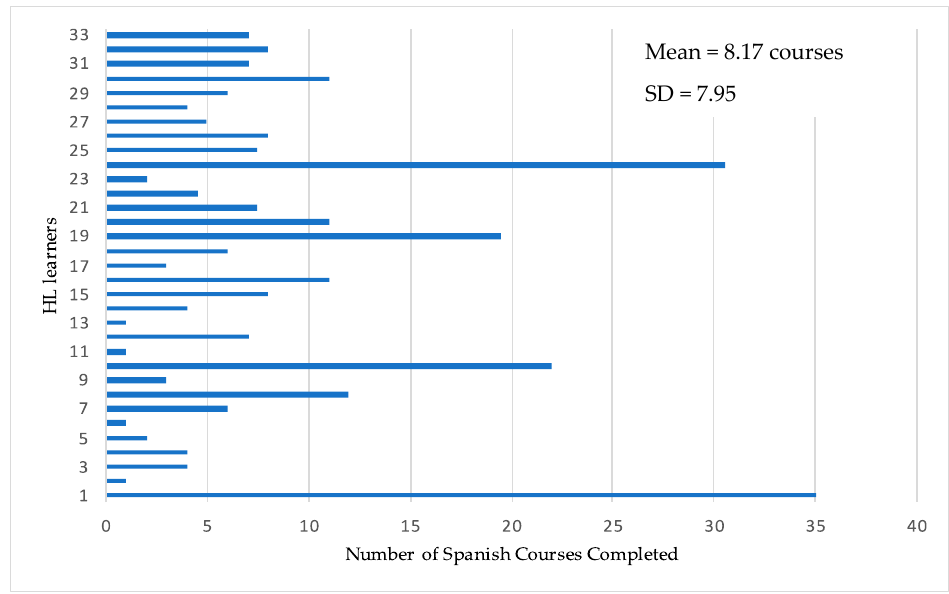
Figure 9. Number of Spanish courses completed by the HL learners.